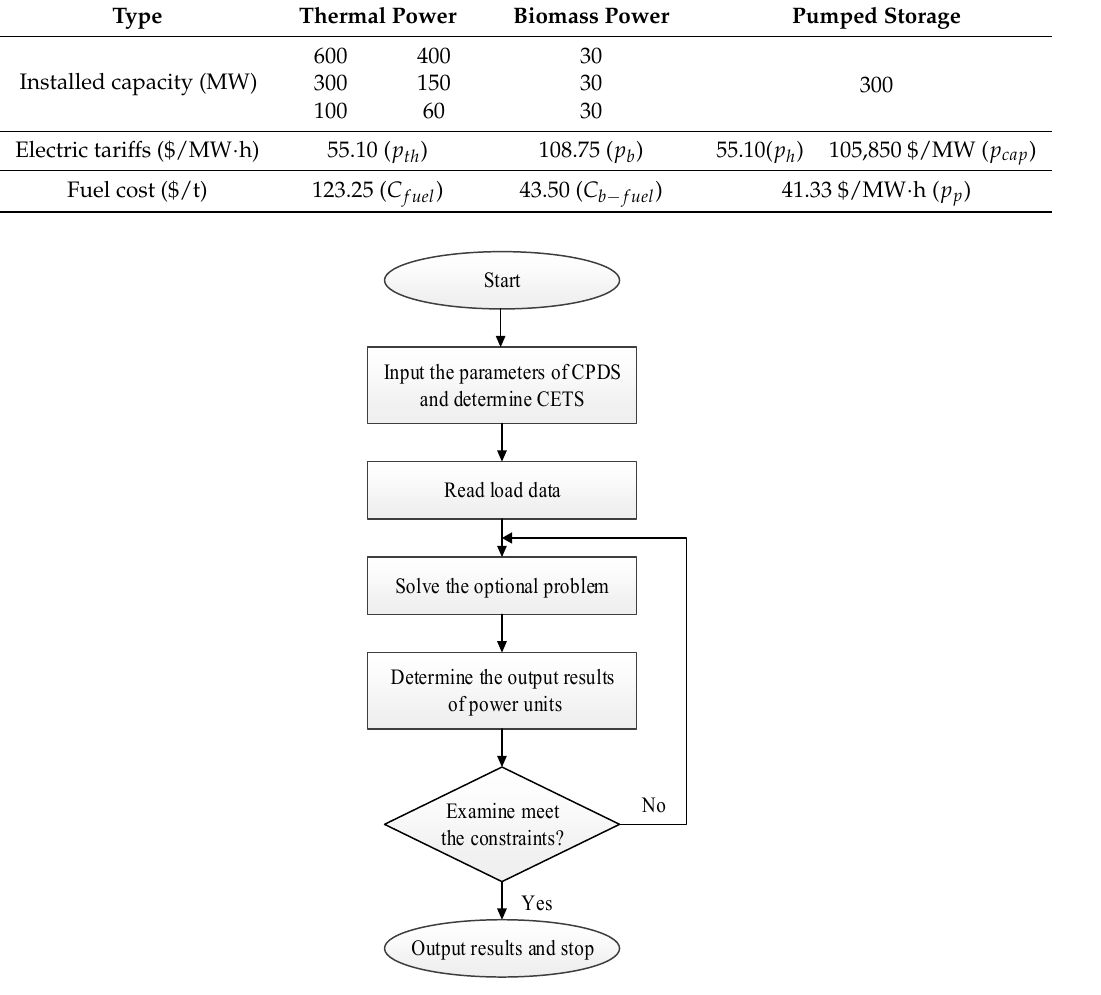
Figure 2. Flow diagram of the optimization model.